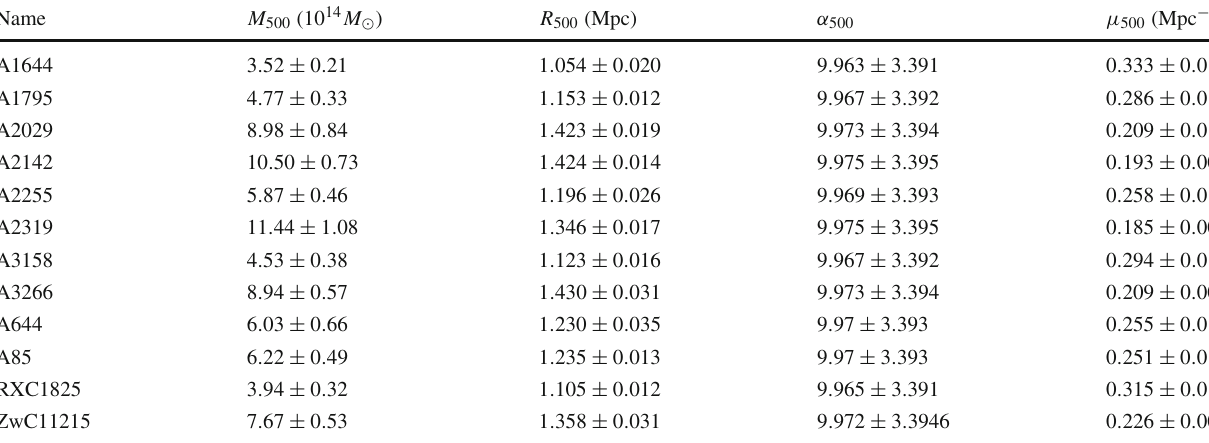
Table 2 Best fit values for α 500 and μ 500 estimated for X-COP cluster